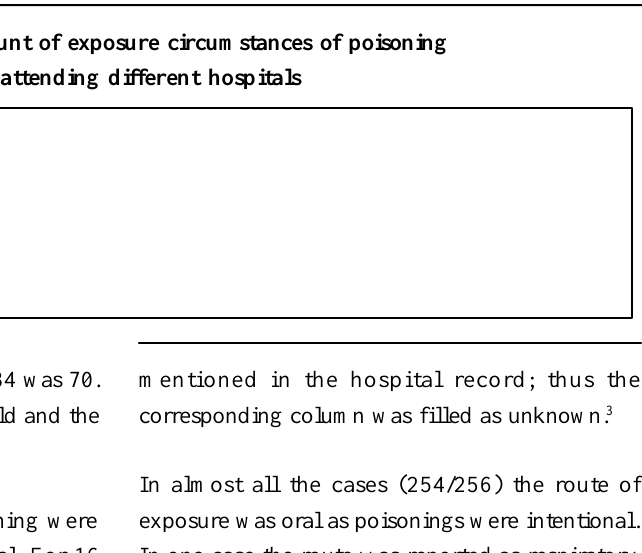
Table III : Total count of exposure circumstances of poisoning